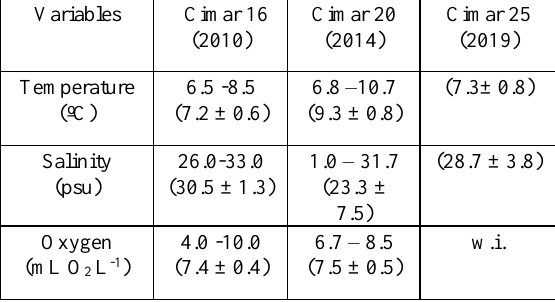
Table 1. Main oceanographic features of three estuaries